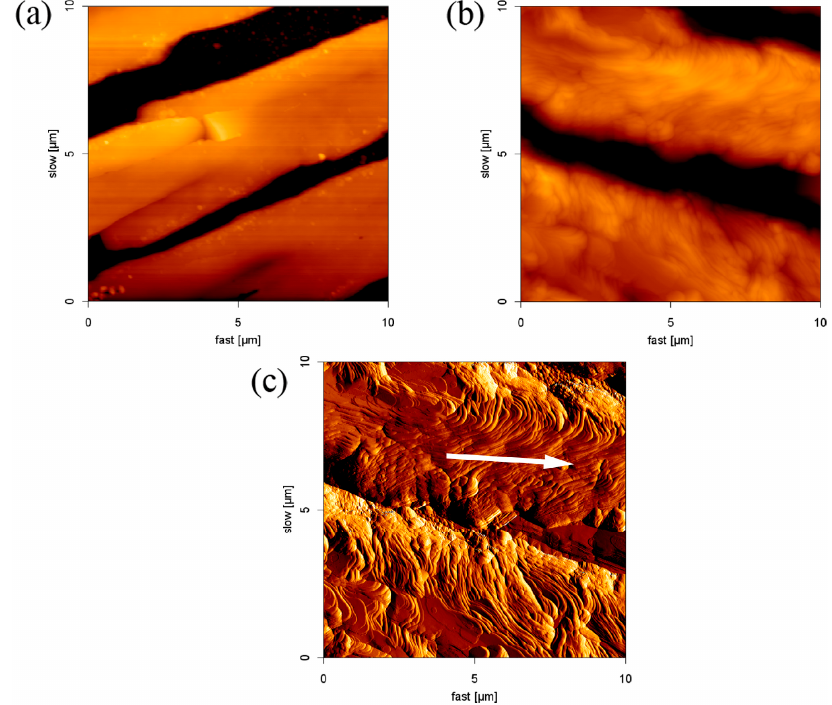
Figure 2. AFM images (10 μ m × 10 μ m) ( a ) at 2 mM and ( b ) at 8.1 mM; and ( c ) AFM error signal image from (b).